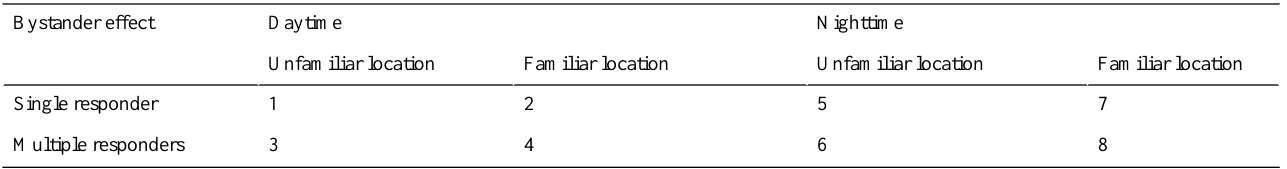
Table 1. Decision factors’research